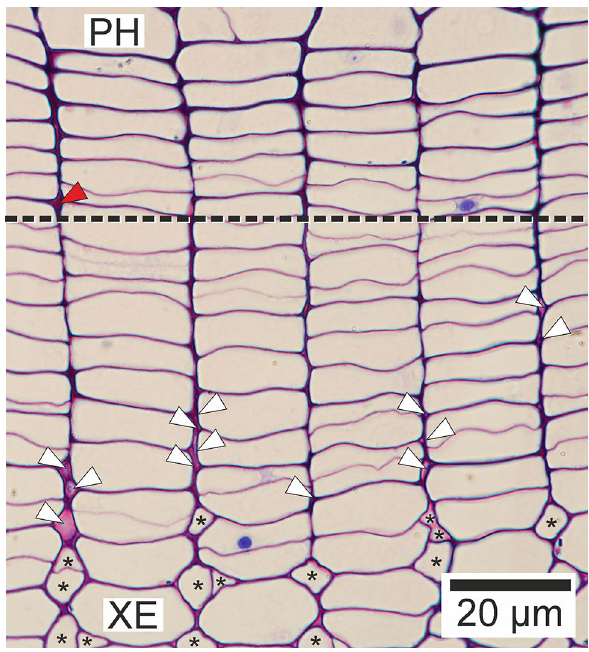
Figure 3. Transverse section of the vascular cambium and derivative cells collected from the tree trunk of Robinia pseudoacacia L. Black, dashed line indicates approximate location of cambial initial layer. PH— secondary phloem side. XE—secondary xylem side. White and red arrowheads indicate microspaces at various stages of their formation, including spots of loosening (fluidization understood as change in viscosity) of middle lamellae. Red arrowhead precedes intrusive growth of an initial cambial cell. White arrowheads precede intrusive growth of wood fibre tips. Asterisks indicate growing tips of libriform wood fibres. Adobe Photoshop CS6 Extended ver.13.0 × 64 (https:// www. adobe. com), and CorelDRAW Graphics Suite SE ver. 18.2.0.840 (https:// www. corel draw. com) were